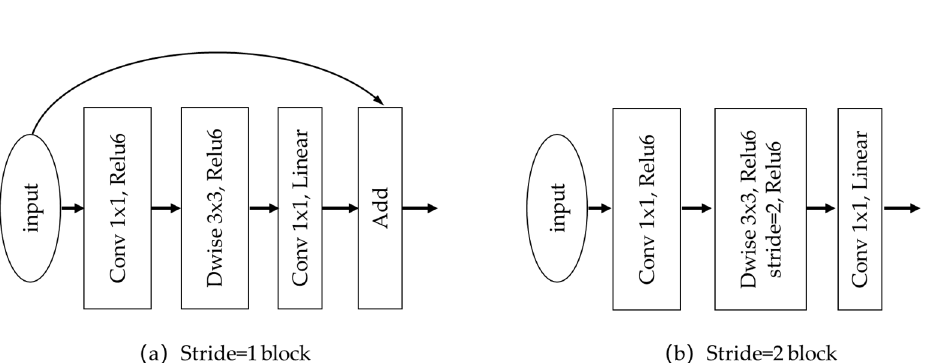
Figure 2. The inverted residual block in MobileNet-v2. It has two structures, and when the stride = 2, the size of the feature map is downsampled by two times. Dwise is a deep-wise separable convolution proposed by MobileNet.